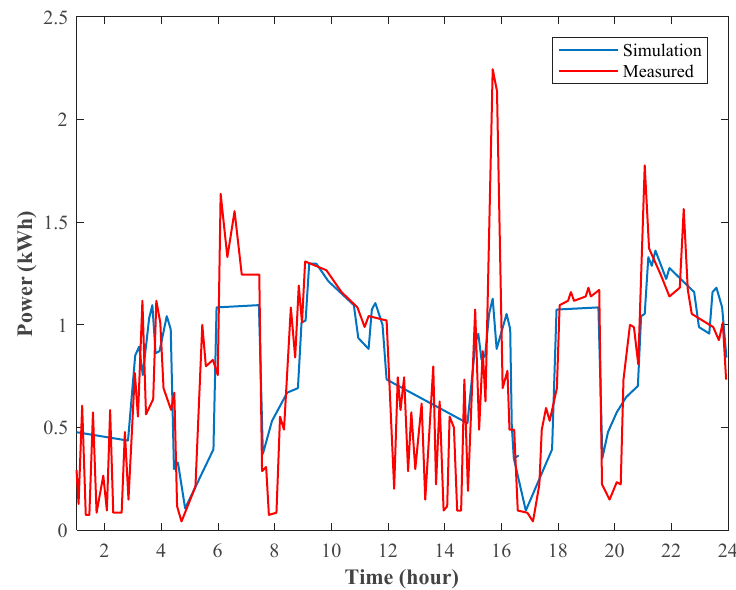
Figure 4. Simulated and measured hourly electricity usage of building 2.